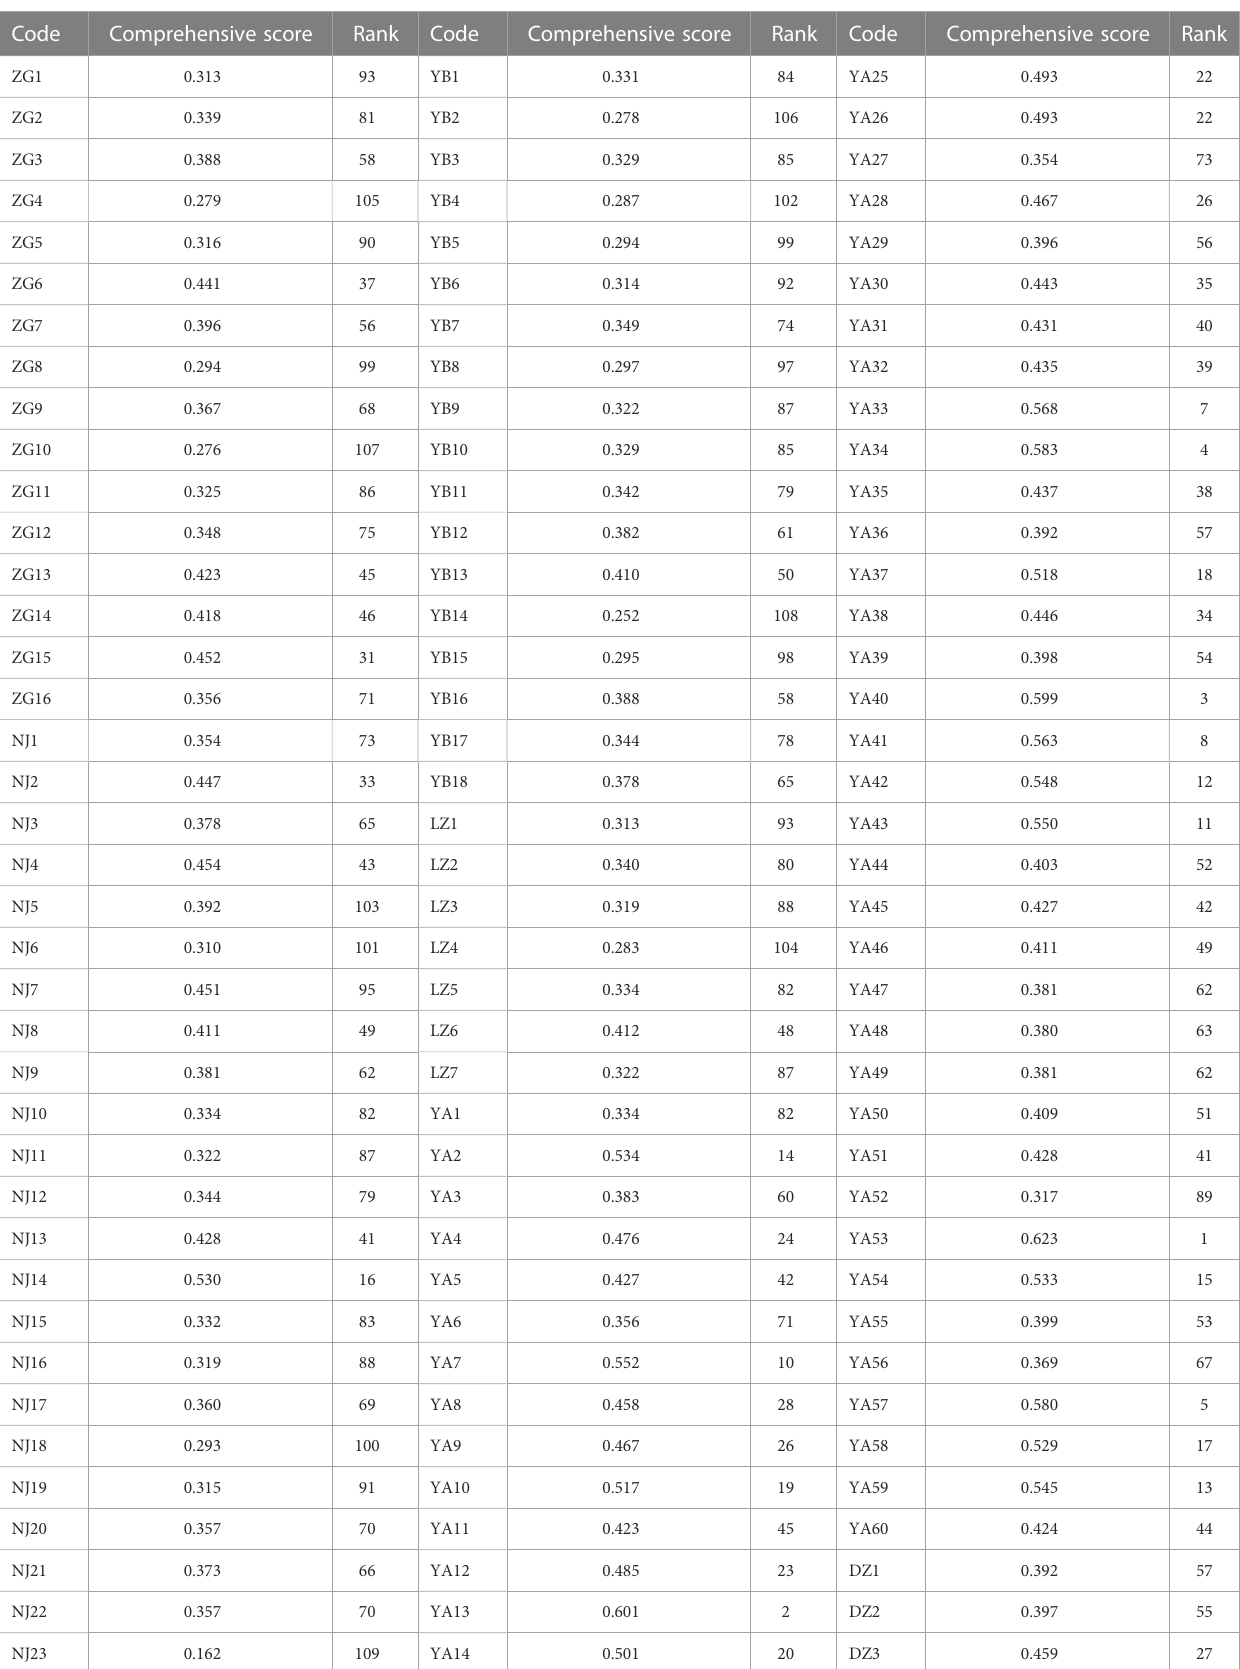
TABLE 5 Comprehensive score and ranking of 143 C . oleifera germplasm resources. Code Comprehensive